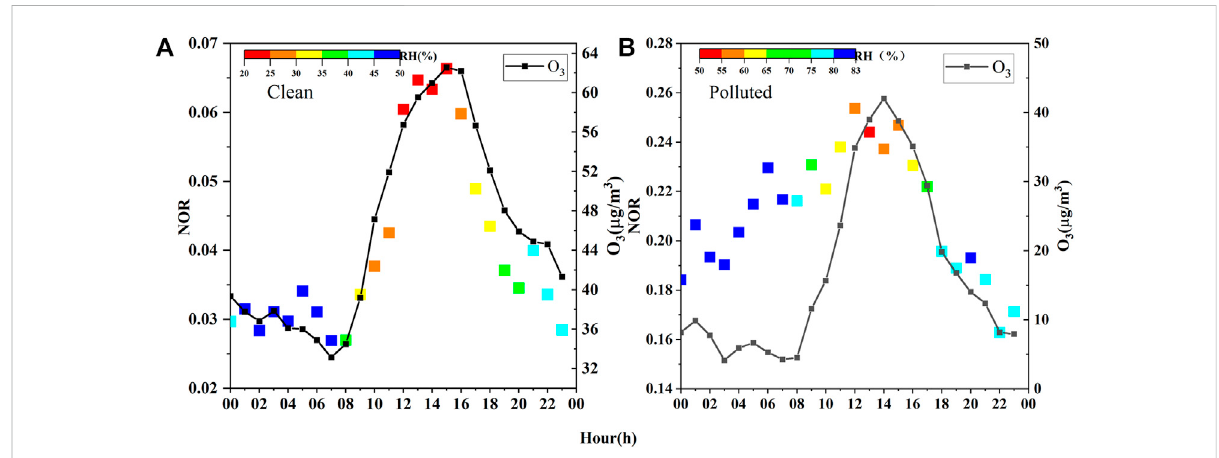
FIGURE 10 Diurnal variation of O 3 and NOR colored by RH (A) during the clean period and (B) during the polluted